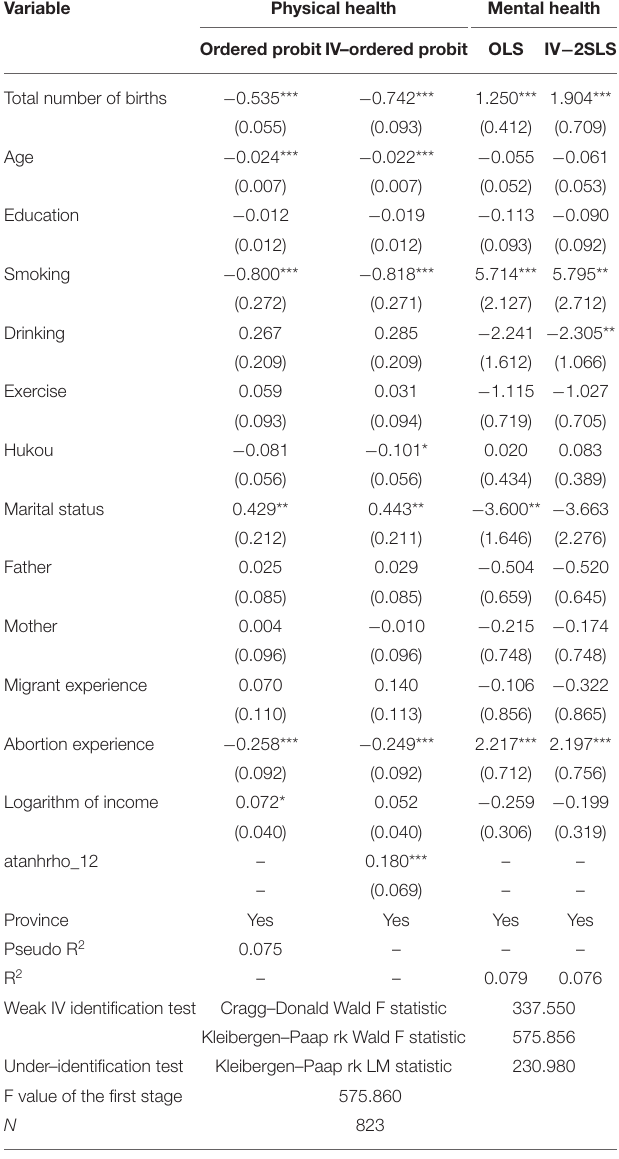
TABLE 6 | Robustness check of using the CLDS2016 and teasing out the effect of abortion. Variable